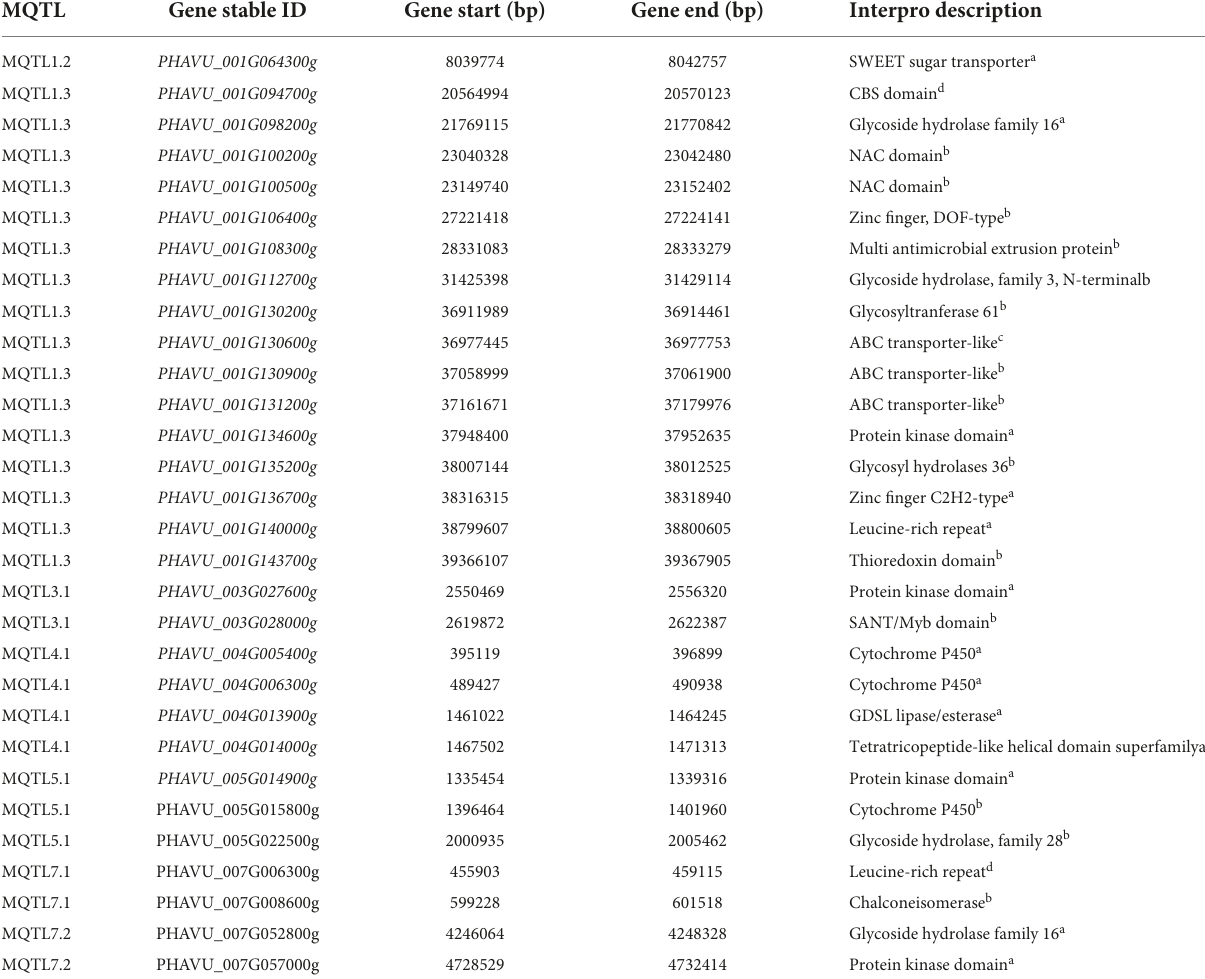
TABLE 4 List of candidate genes identified within the physical intervals of Meta-QTLs (MQTLs) validated through differential